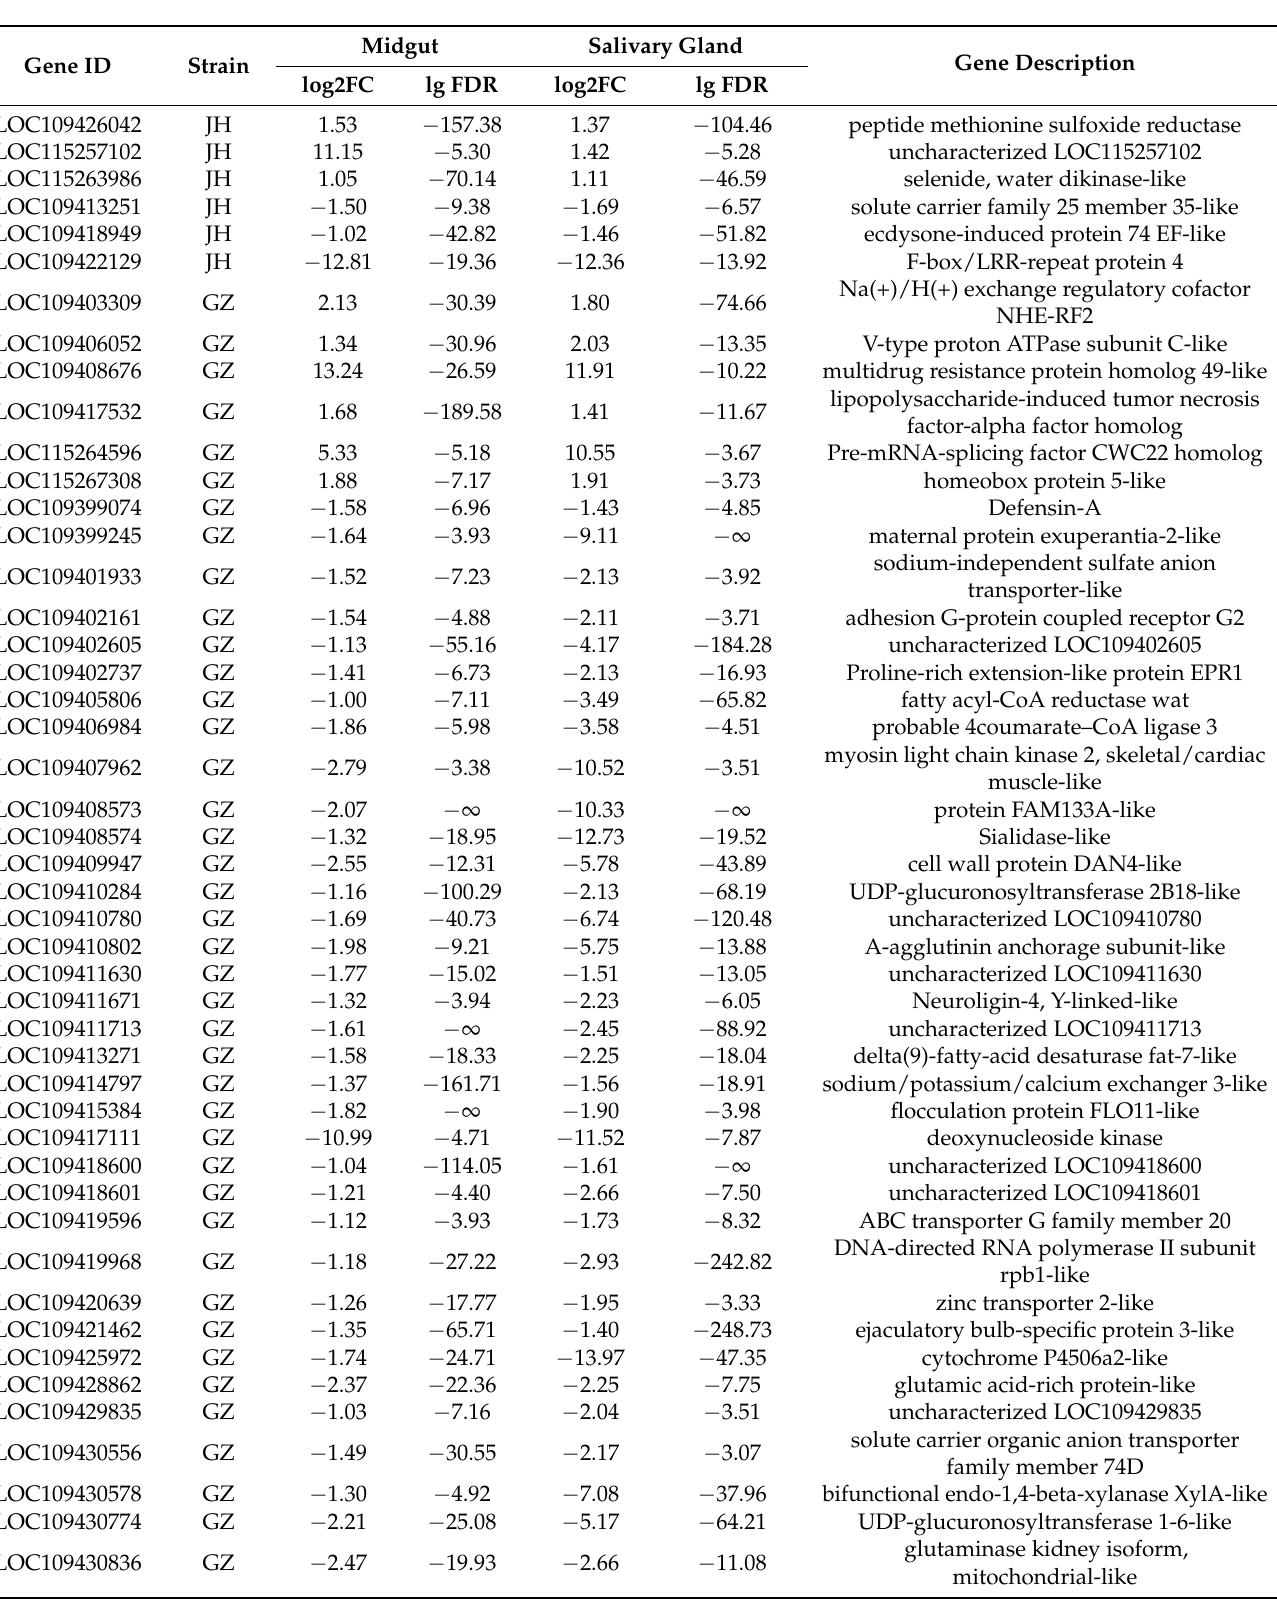
Table 1. DEGs that are regulated in the same direction in both the midgut and salivary gland tissues of the JH and GZ strains after ZIKV